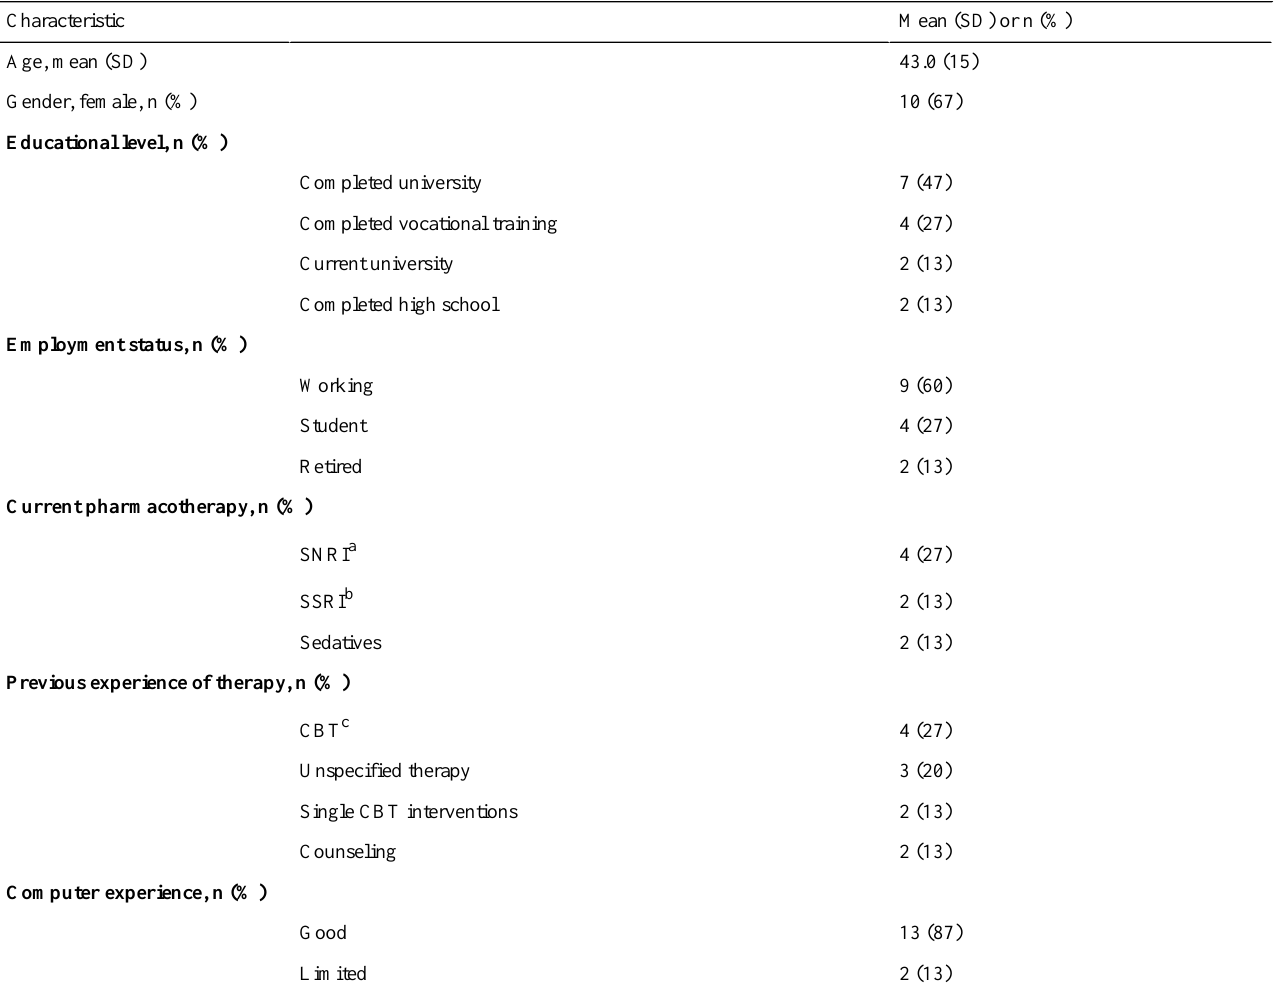
Table 1. Demographic characteristics